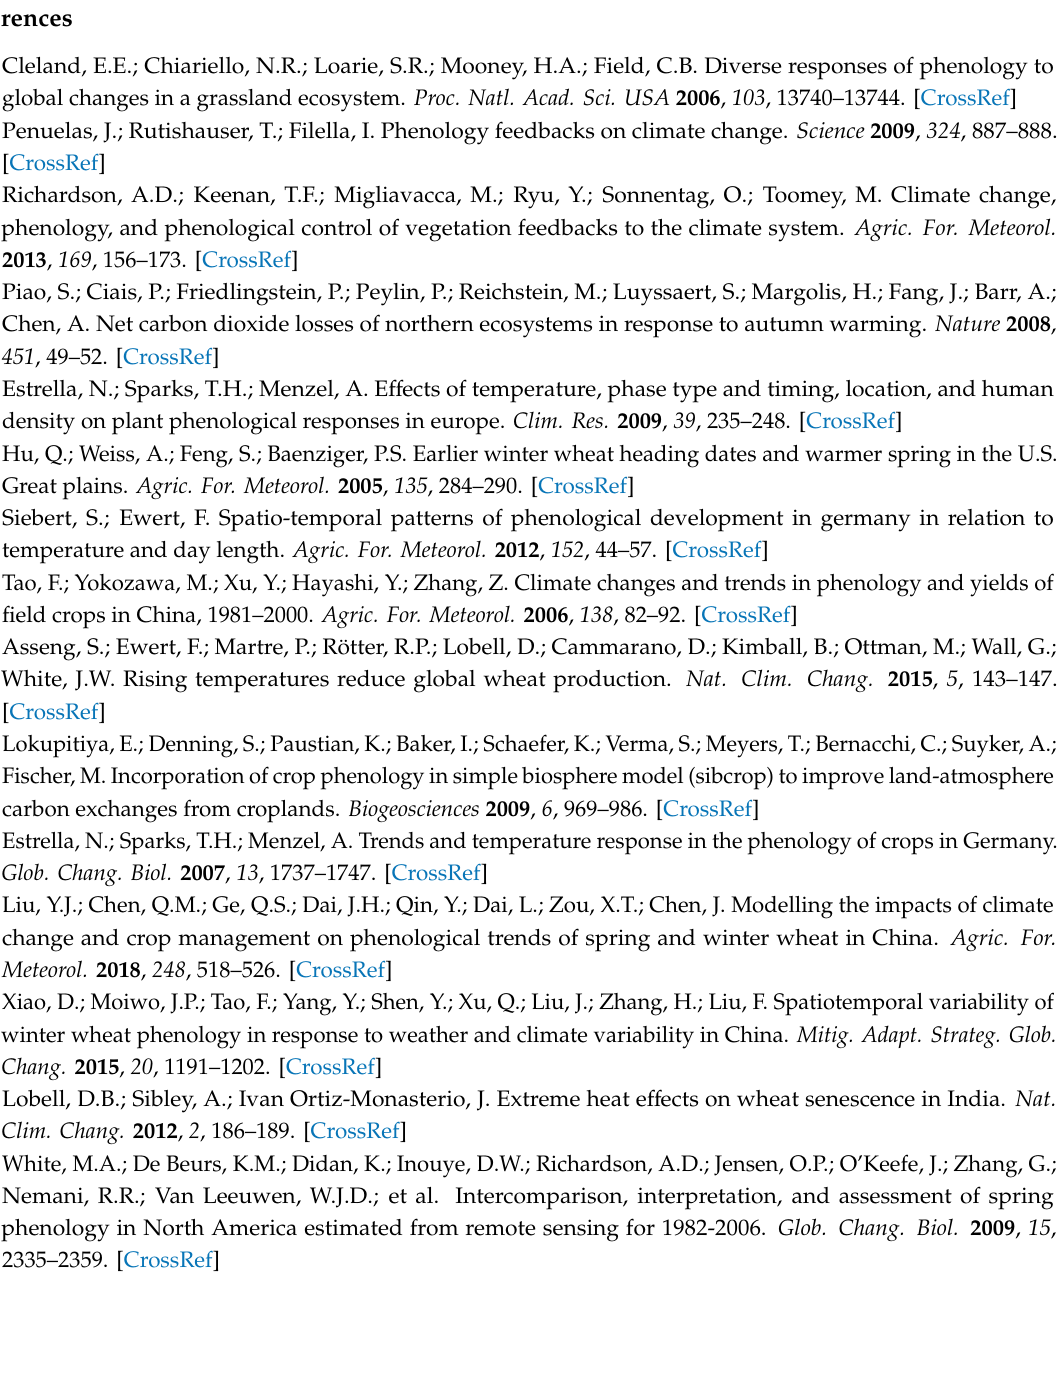
SPEI. Figure S4. Correlation of spatial pattern of serious drought events measured by PDSI and SPEI for (a)